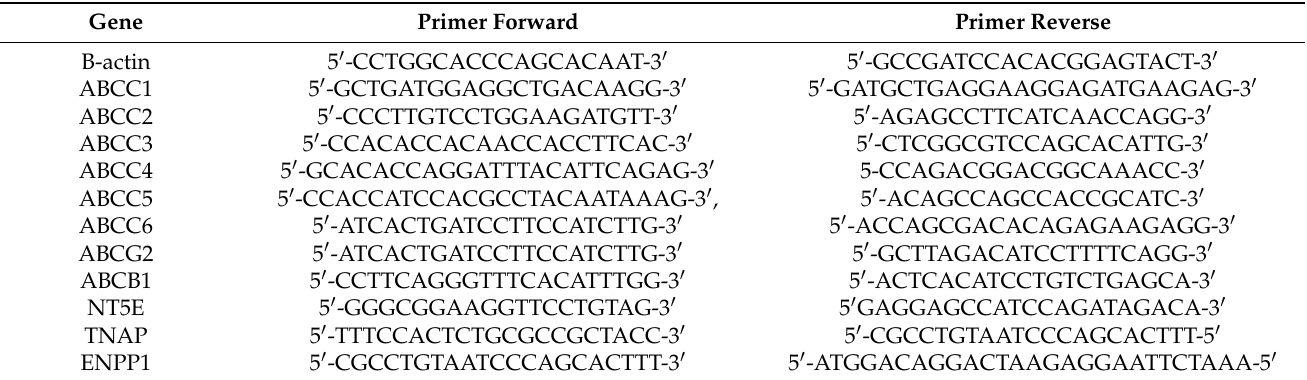
Table 1. List of primers used in this